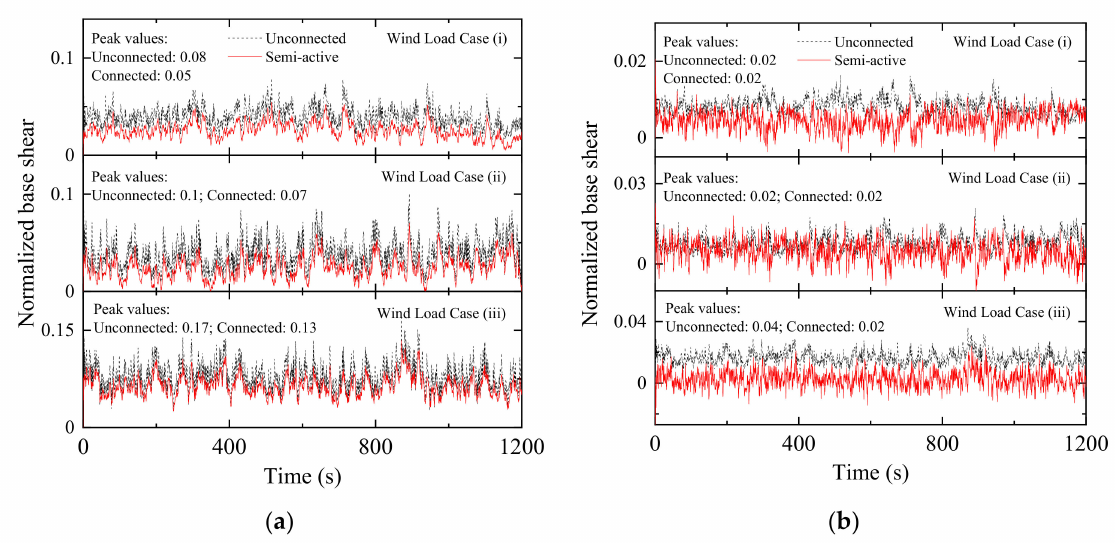
Figure 22. Time history of normalized base shear under wind excitation in: ( a ) a building on the upwind side and ( b ) a building on the downwind side when stiff adjacent buildings are connected using semi-active MR dampers following damper Configuration 1.